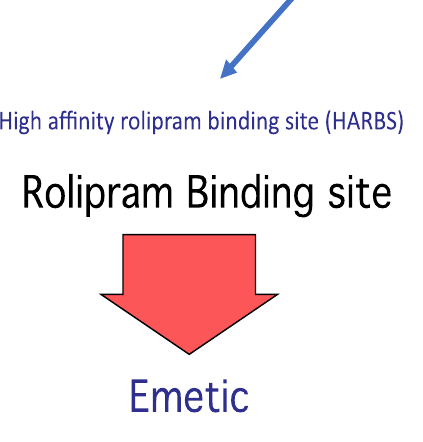
Figure 4. PDE4 inhibitors molecular mechanisms [24 – 26].